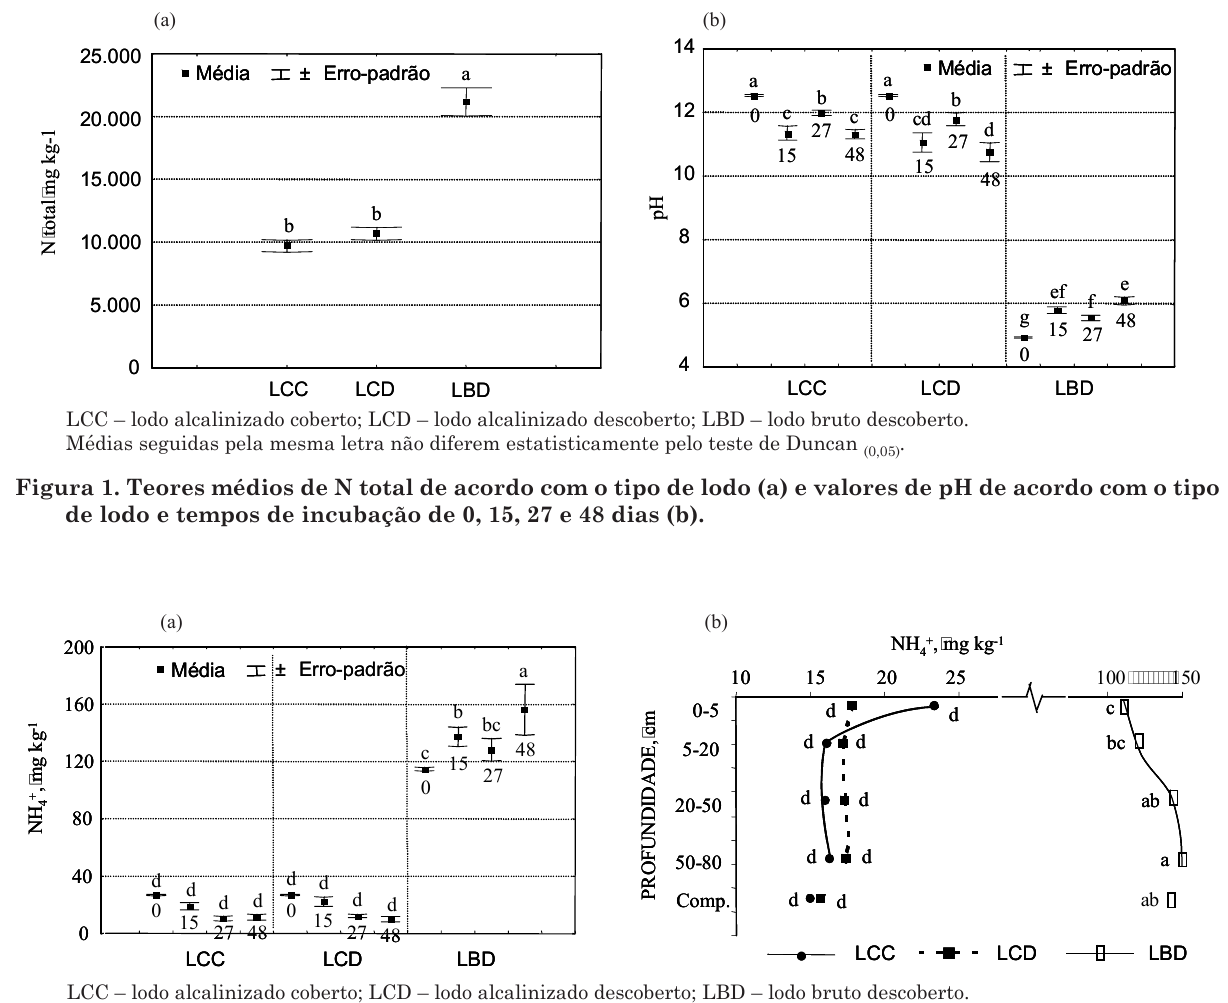
Figura 2. Teores de N-NH 4+ nos diferentes tipos de lodo de acordo com: (a) os tempos de incubação de 0, 15, 27 e 48 dias; (b)